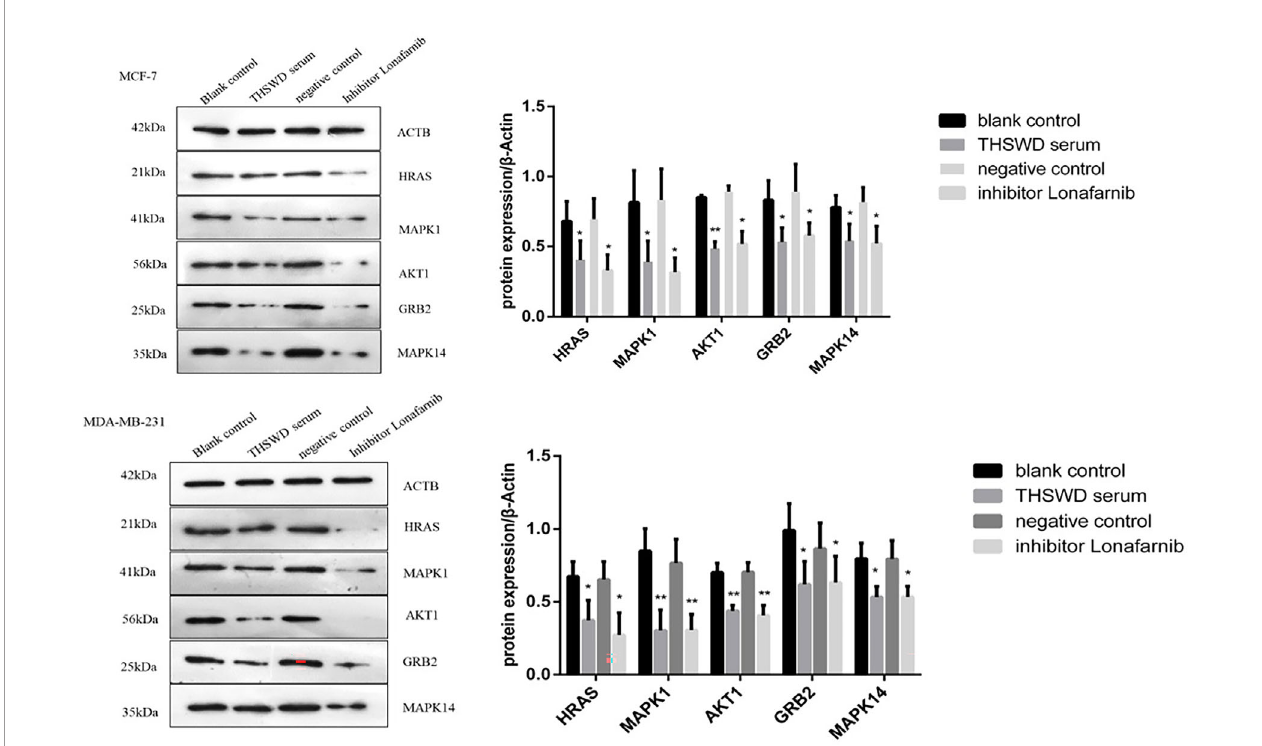
FIGURE 11 | Effect of serum containing THSWD on the protein expression of HRAS, MAPK1, AKT1, GRB2 and MAPK14 in MCF-7 and MDA-MB-231 cells. *P < 0.05, **P < 0.01 compared with blank control